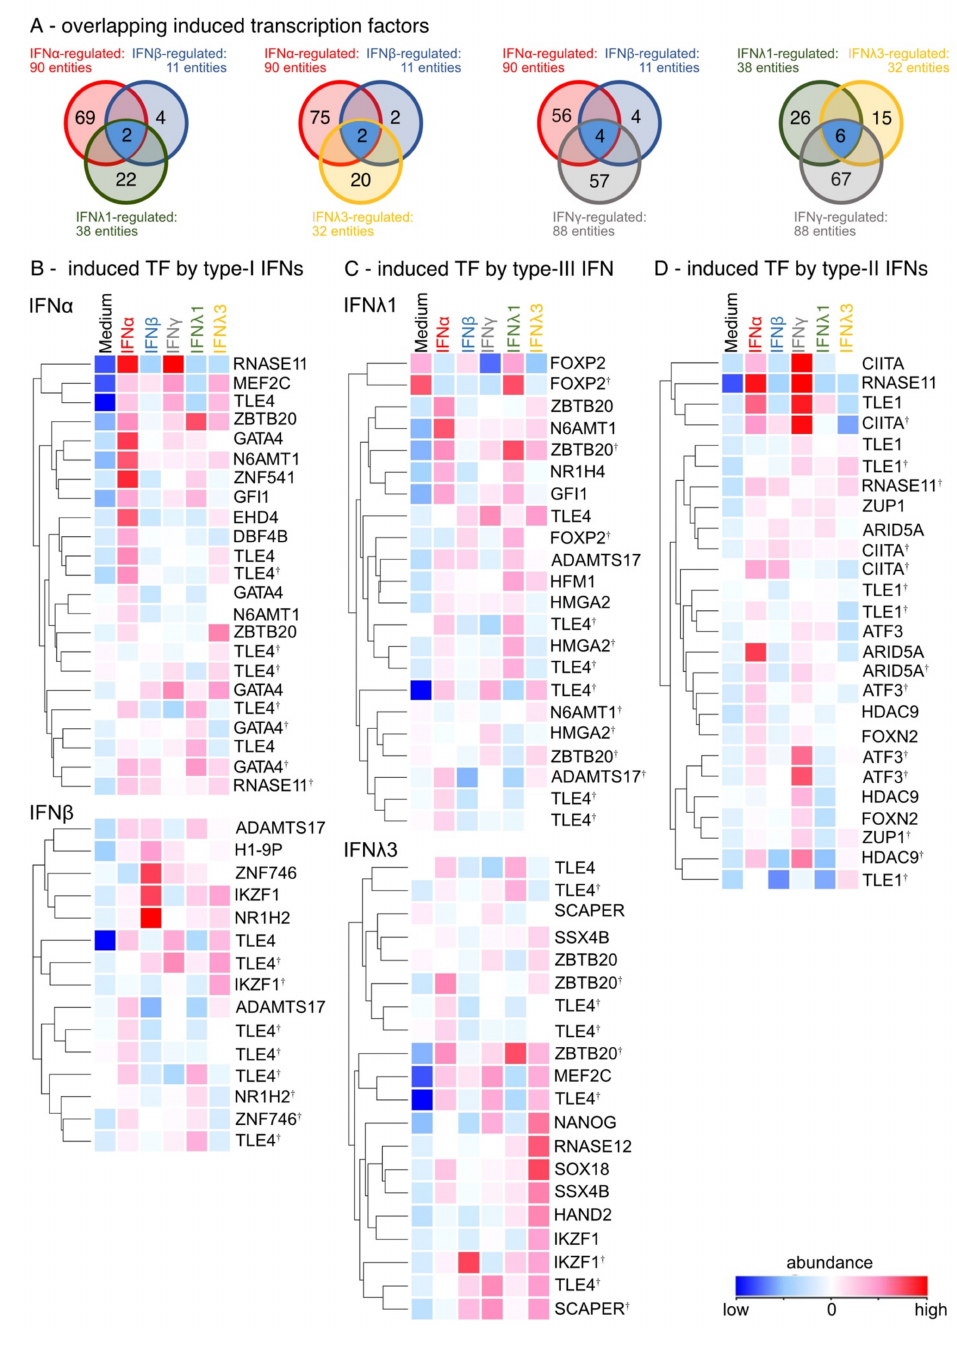
Figure 3. IFN family members differentially induce transcription factors. ( A ) Venn blot of overlapping regulated transcription factors by type-I, -II and -III IFNs. Ttest IFN α -stimulated vs. ttest IFN β - stimulated and ttest IFN λ 1-stimulated. Ttest IFN α -stimulated vs. ttest IFN β -stimulated and ttest IFN λ 3-stimulated vs. unstimulated. Ttest IFN α -stimulated vs. ttest IFN β -stimulated and ttest IFN γ -stimulated. Ttest IFN λ 1-stimulated vs. ttest IFN λ 3-stimulated and ttest IFN γ -stimulated. Blue: overlapping DEGs. ( B ) Heat map of induced transcription factors by type-I IFNs (ttest IFN α - stimulated; ttest IFN β -stimulated vs. unstimulated). Duplicate gene names indicate the abundance of two or more transcripts of the same gene in the analysis and are marked with a cross. ( C ) Heat map of induced transcription factors by type-III IFNs (ttest IFN λ 1-stimulated; IFN λ 3-stimulated vs. unstimulated). ( D ) Heat map of induced transcription factors by type-II IFNs (ttest IFN γ -stimulated vs.